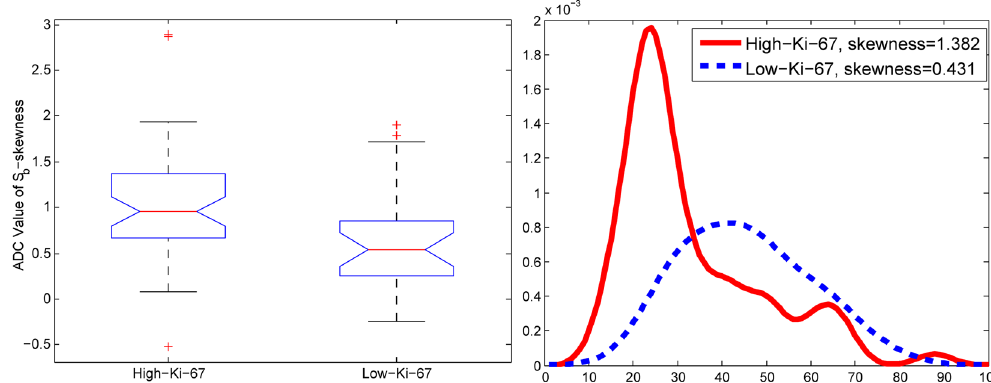
Figure 4. An example of the skewness feature of ADC values in the tumour boundary region. ( a ) Boxplot of skewness of ADC values in a tumour boundary for high and low Ki-67. ( b ) An example of high and low Ki-67 cases, with a density of ADC values in the tumour boundary.